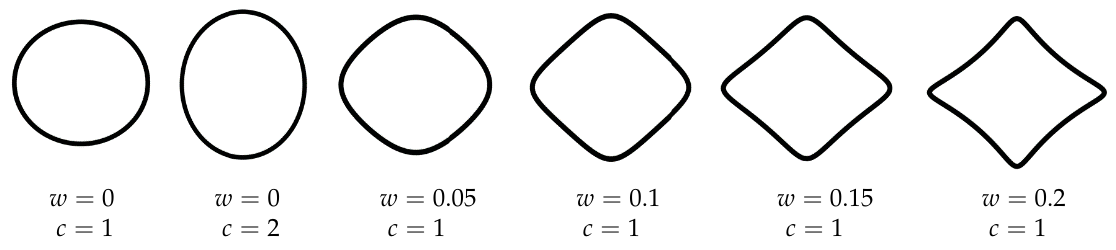
Figure 4. Effect of w on the shape of quasi-square cutout ( c = 1).